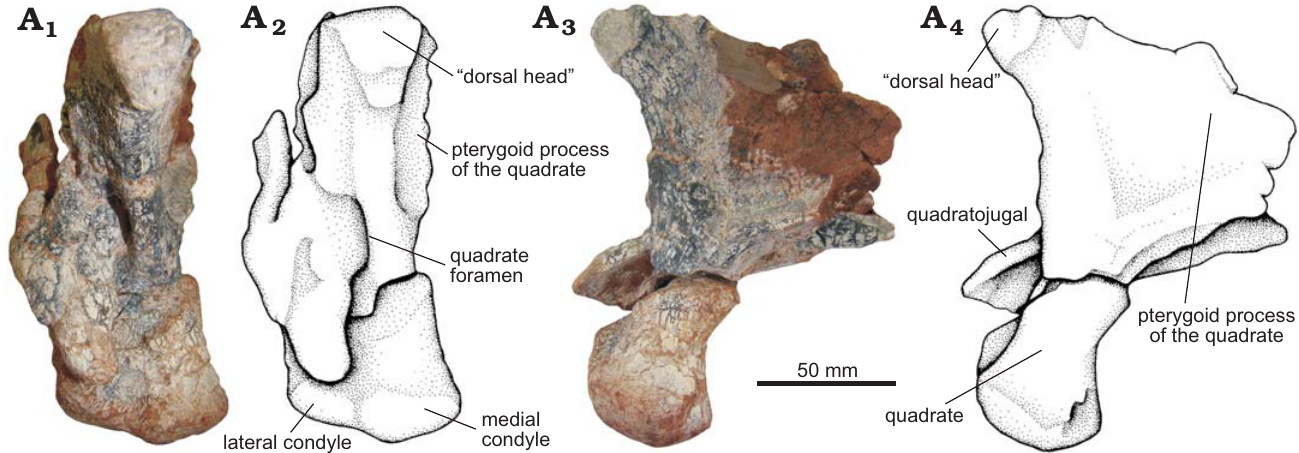
Fig. 14. The pseudosuchian archosaur Prestosuchus chiniquensis Huene, 1938 (UFRGS-PV-0629-T) from the Dinodontosaurus Assemblage Zone, Ladinian, Middle Triassic, Dona Francisca municipality, Rio Grande do Sul State, Brazil; left quadratojugal and quadrate in posterior (A 1 , A 2 ) and medial (A 3 , A 4 ) views. Photographs (A 1 , A 3 ) and explanatory drawings (A 2 , A 4